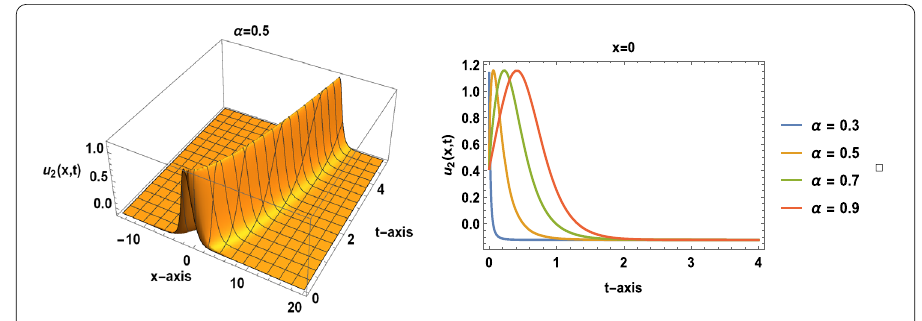
Figure 1 Graphical depiction of the solution given in Eq. (21) when k = 2, s = 0.8, w = 0.1